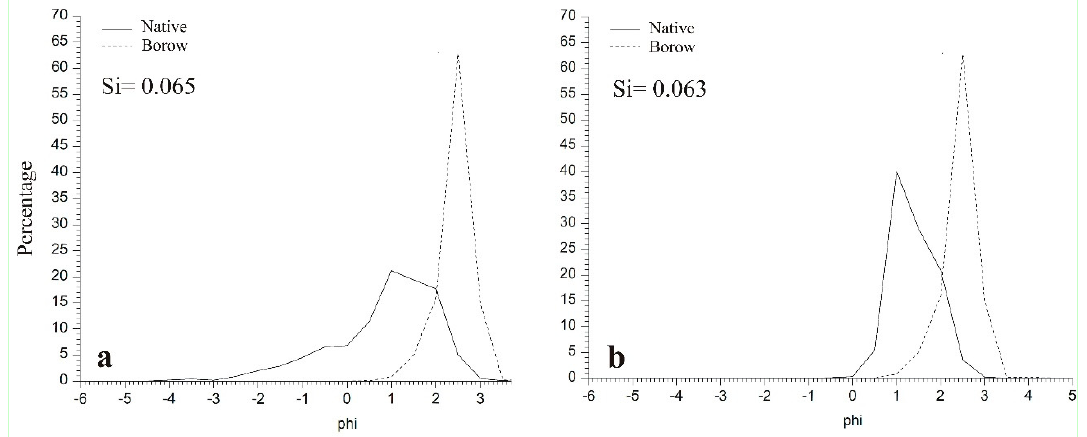
Figure 12. Grain size distribution of the composite sample formed with five samples from Pietrasanta beach (Sector 7, borrowed sand in a , b ) and that representing the native beach sand at Ronchi (Sector 5, a ) and north of the R. Morto beach (Sector 12, b ), both averaging three samples.